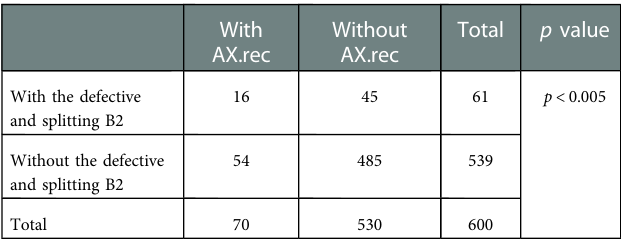
TABLE 4 Distribution of AX.rec in the defective and splitting B2 type.